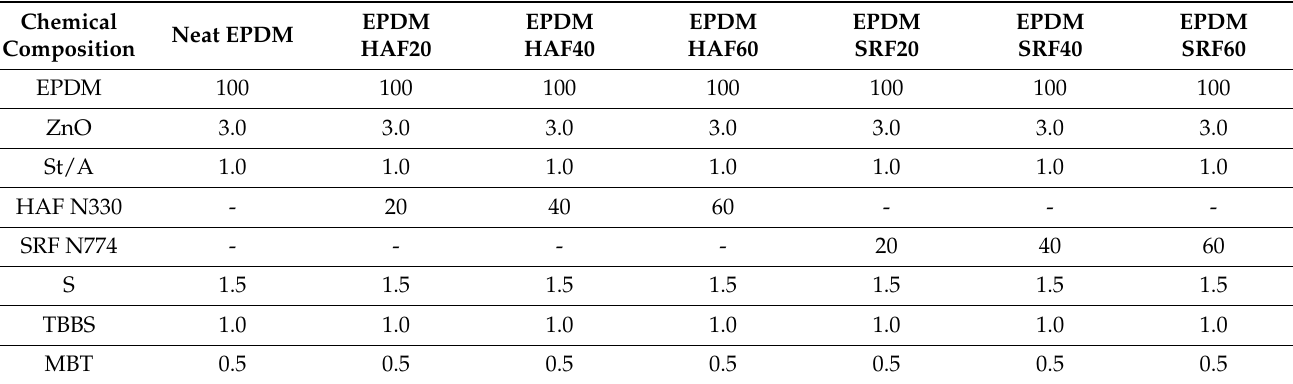
Table 1. Composition of the EPDM series with HAF and SRF CB fillers.